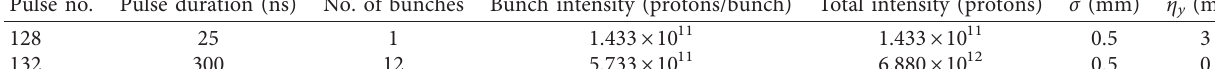
Table 5: Beam parameters for the studied impacts (pulse 128 and pulse 132). Pulse no.